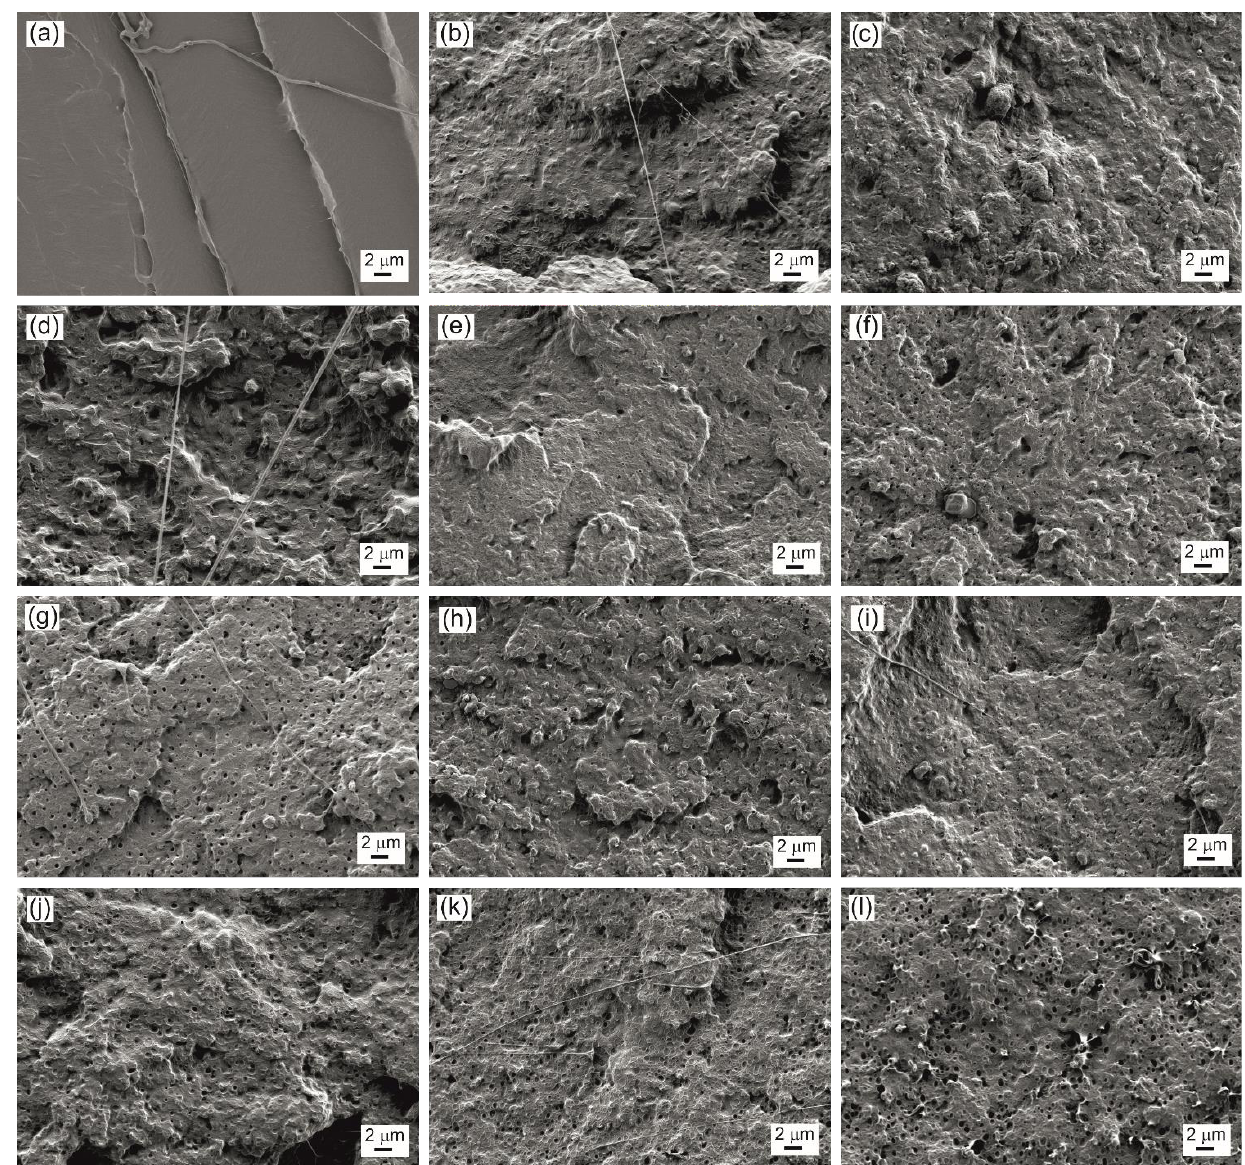
Figure 5. FESEM images at 2500× of fracture surface of ( a ) PLA; ( b ) PLA – PHB blend (B); ( c ) B-1ECO; ( d ) B-2.5ECO; ( e ) B-5ECO; ( f ) B-7.5ECO; ( g ) B-10ECO; ( h ) B-1MCO; ( i ) B-2.5MCO ( j ) B-5MCO; ( k ) B-7.5MCO; and ( l ) B-10MCO.